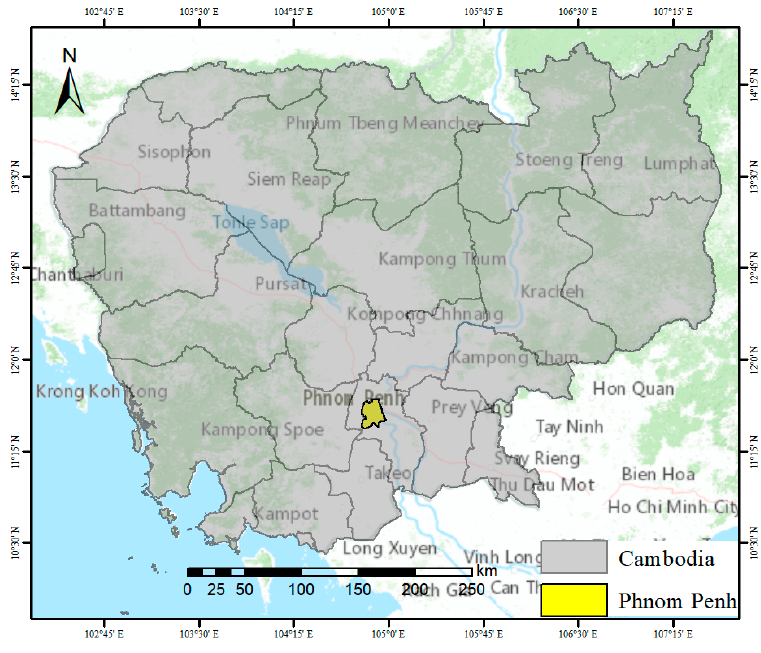
Figure 2. Study area.